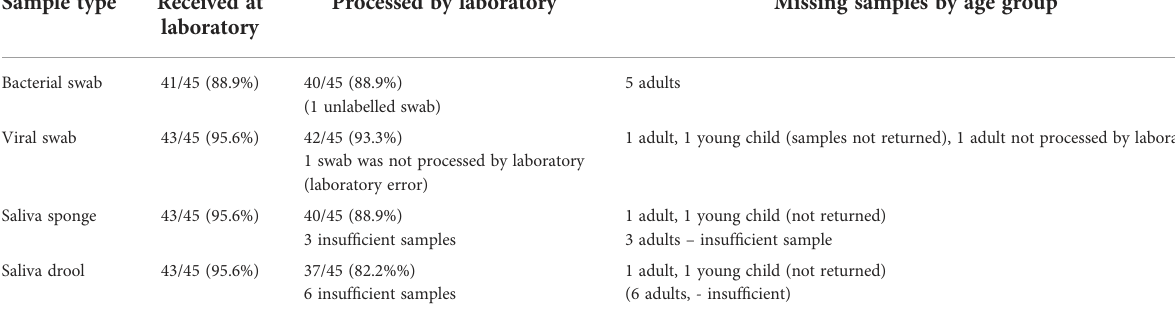
TABLE 3 Stage 2 samples/tests received and processed for bacterial and viral analysis. Sample type